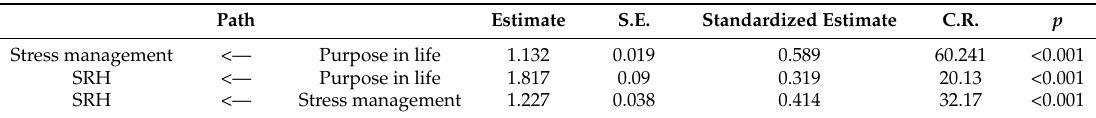
Figure 1. The structural equation model of the relationship between purpose in life, stress management and SRH. (*** p < 0.001). Table 4. The path coefficients between structural variables.